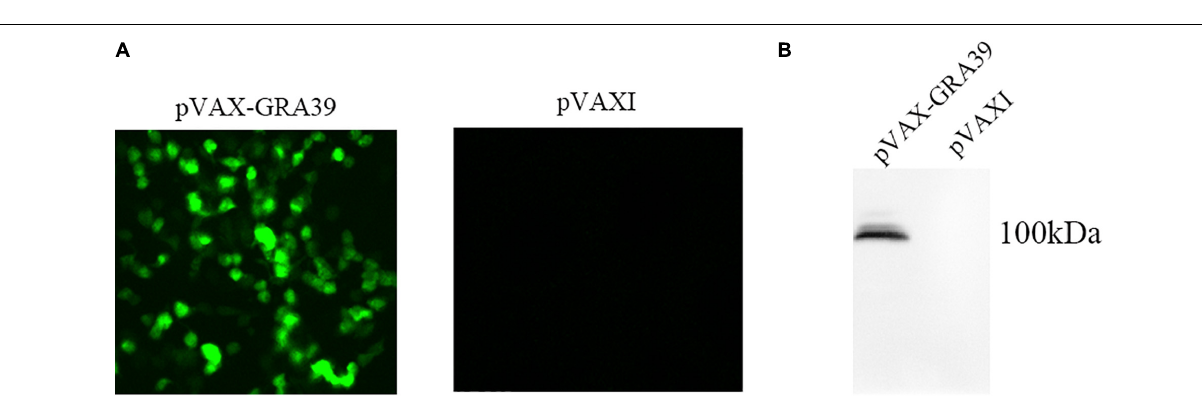
FIGURE 2 | Expression of pVAX-GRA39 in Marc-145 cell. (A) Immunofluorescence assay for the recombinant GRA39 protein expressed in Marc-145 cells. (B) Western blotting analysis of the expression of GRA39 in Marc-145 cell lysates and empty pVAX